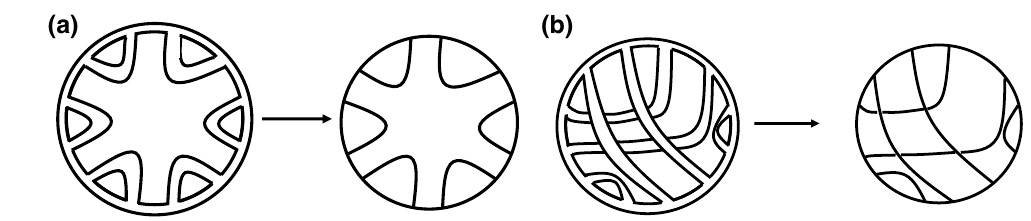
FIG. 5. Double-line diagrams (and the corresponding polygons) obtained from the diagrams of Figs. 3(a) and 4(a).